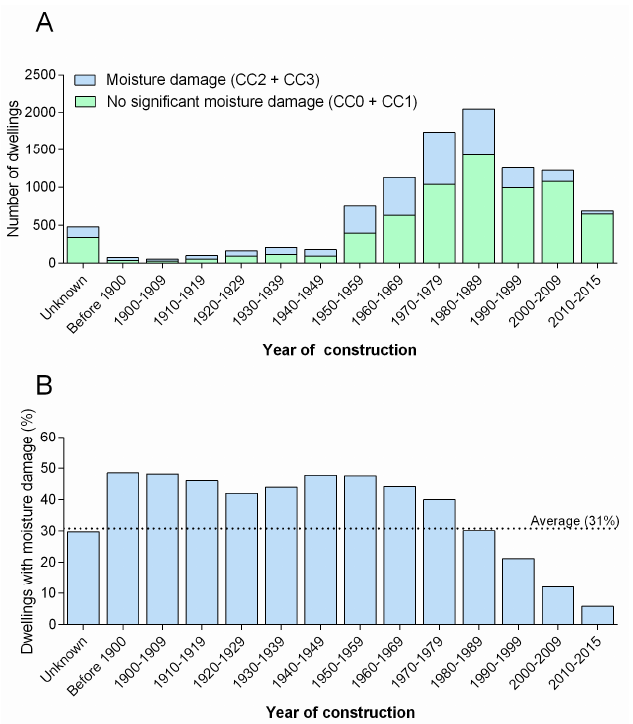
Figure 2. Dwellings with moisture damage distributed by year of construction. The figure shows total number of Norwegian dwellings in this study with and without moisture damage ( A ) and share of dwellings with moisture damage ( B ) grouped after year of construction.